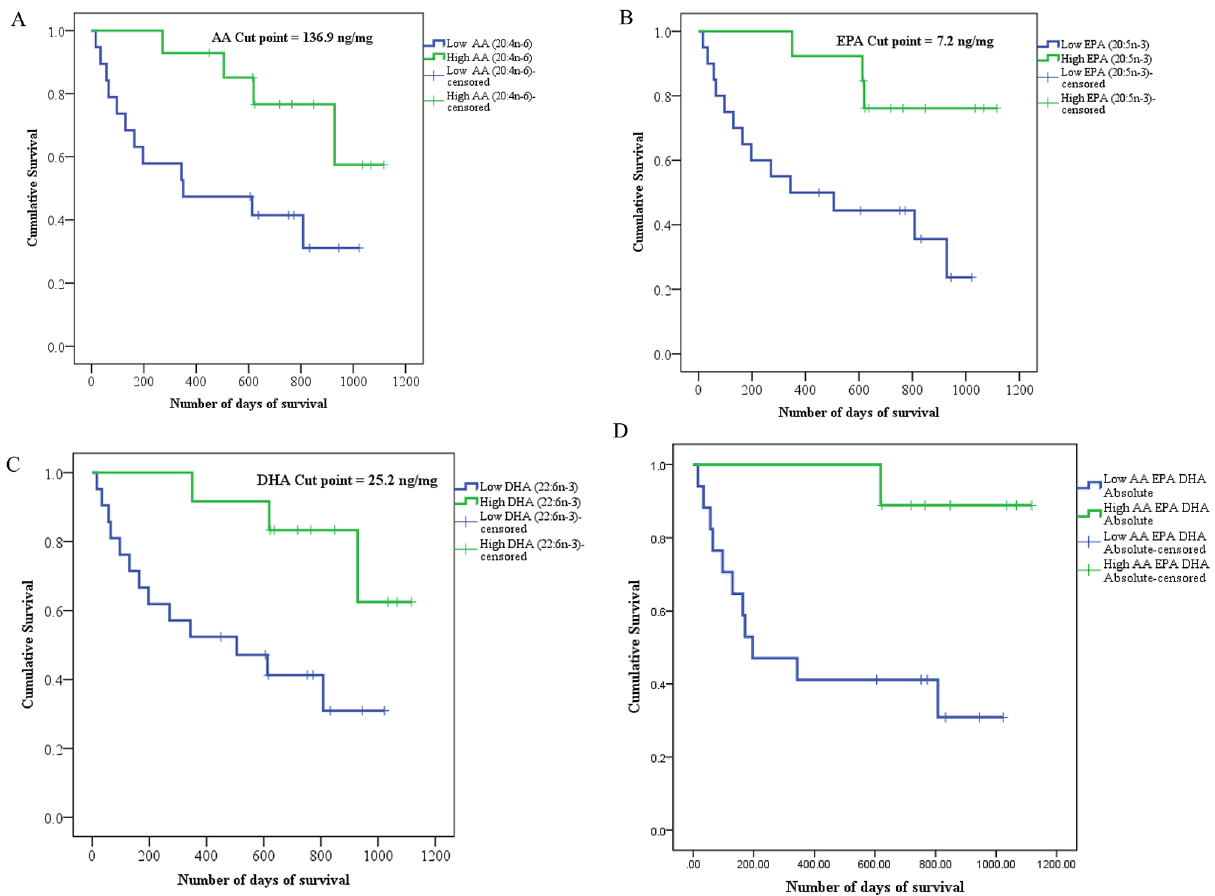
Figure 1. Kaplein–Meier survival curve for patients with low versus high fatty acid content in skeletal muscle phospholipids. ( A – C ) Represent survival distribution of surgical patients with gastrointestinal cancer based on fatty acid cut-points associated with increased mortality risk obtained by optimum stratification and adjusted for sex. ( D ) Represents survival distribution of patients with ARA, EPA and DHA above and below the cut- points. Log-rank tests were used to compare the survival curves of each variable (p <